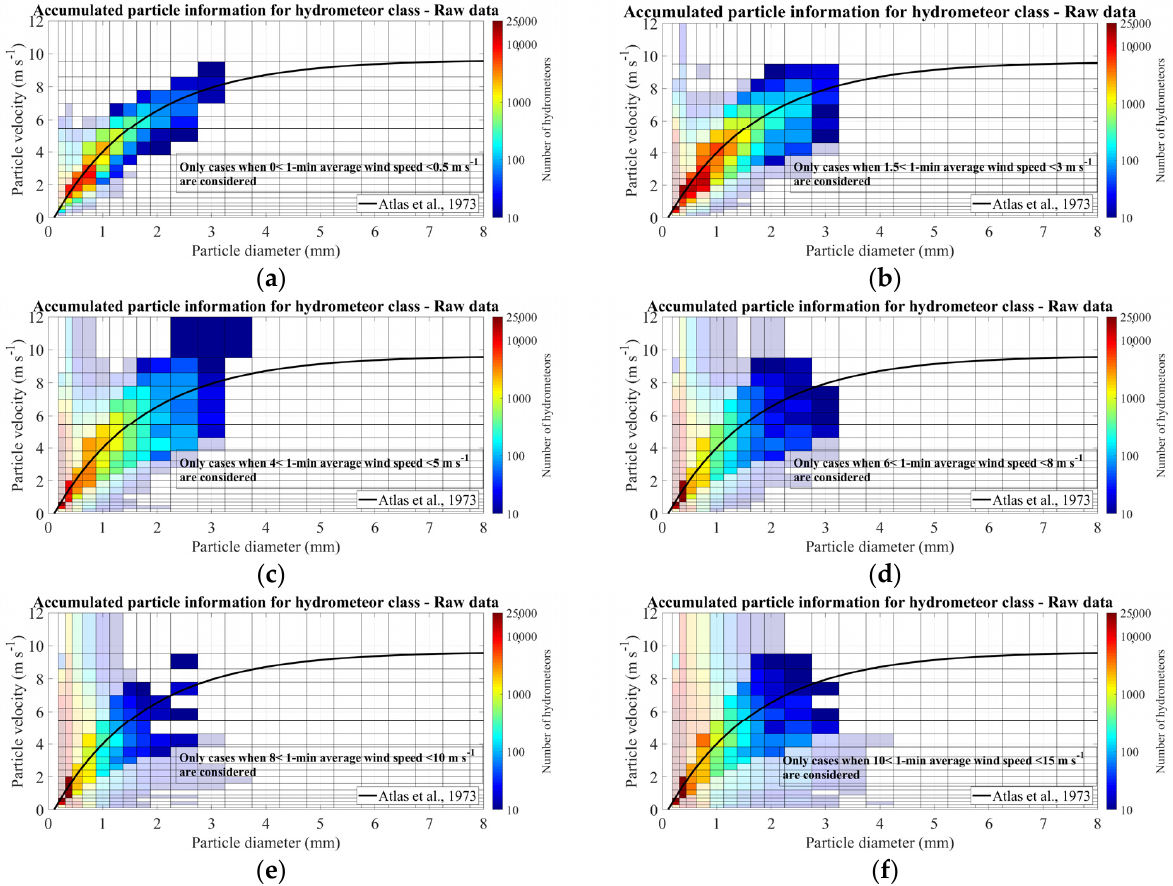
Figure 7. Aggregated Thies spectrograph for different wind speed classes: 0.0–0.5 m s − 1 ( a ), 1.5–3.0 m s − 1 ( b ), 4.0–5.0 m s − 1 ( c ), 6.0–8.0 m s − 1 ( d ), 8.0–10.0 m s − 1 ( e ) and 10.0–15.0 m s − 1 ( f ). The color scale indicates the number of drops in each size-velocity class, and deviations larger than 50% from theoretical drop size-velocity relationship are indicated in transparencies. The empirical relationship between raindrop diameter and fall velocity proposed by [33] is highlighted as black curve.